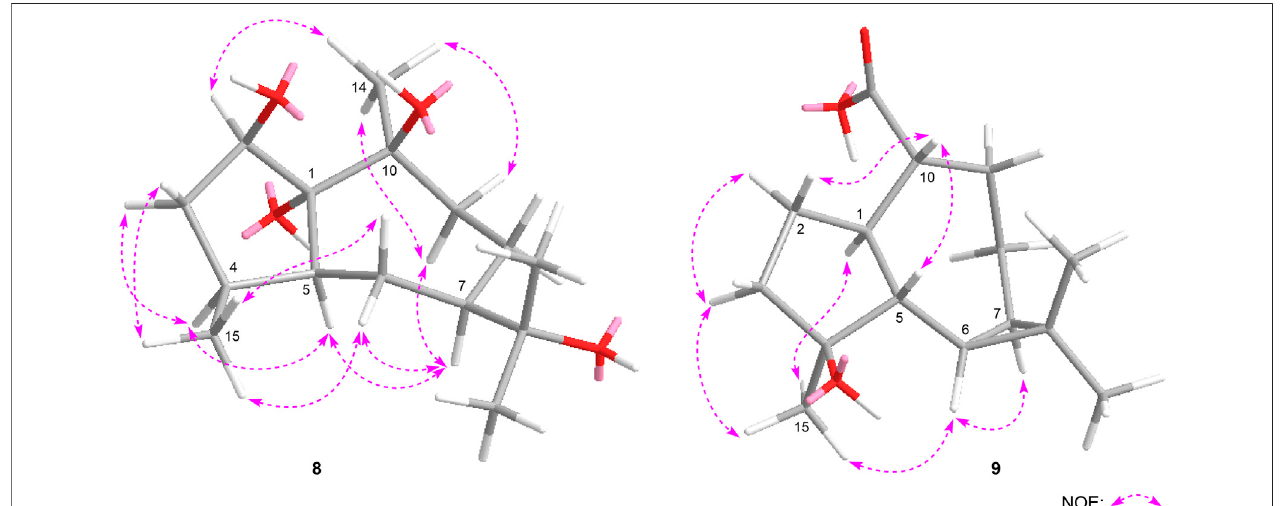
FIGURE 7 | The main NOE correlations of 8 , 9 .